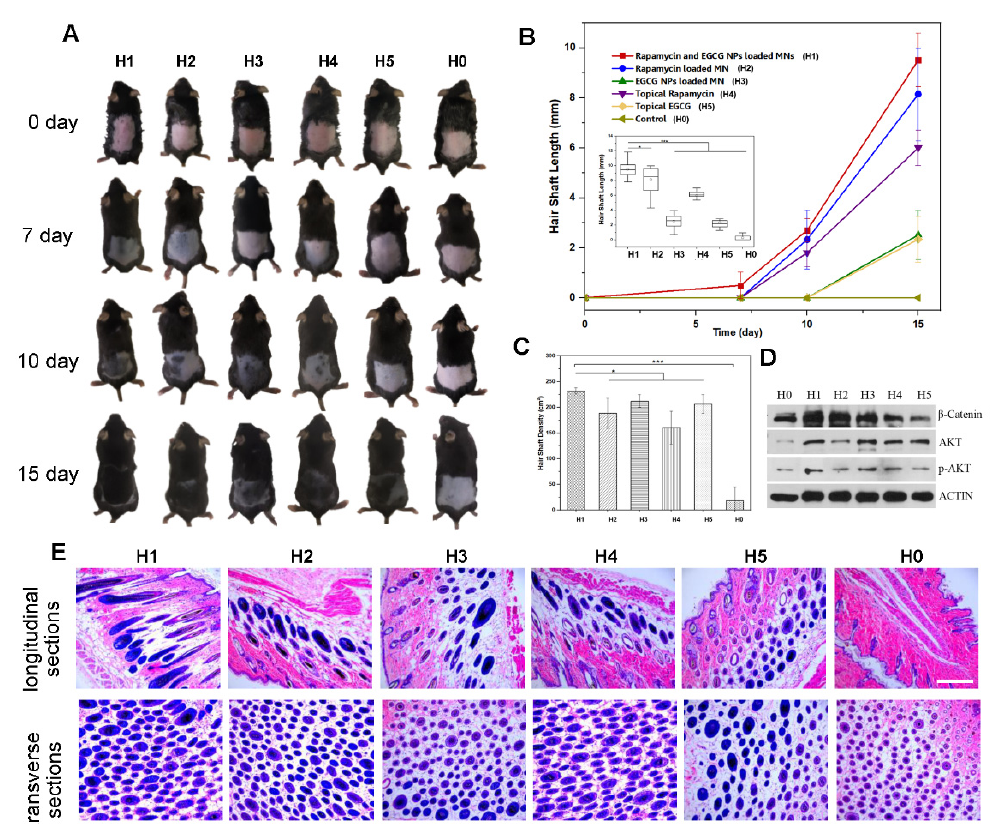
Figure 6. In vivo study of DMN for hair regrowth. ( A ) Physical images of mice treated with RAPA- PLGA and EGCG-KE NP-loaded MNs (H1), RAPA-PLGA-loaded MNs (H2), EGCG-KE NP-loaded MNs (H3), topical RAPA (H4), and topical EGCG (H5). Untreated mice (H0) served as a control. ( B ) Hair shaft analysis chart of new hair grown on treated mouse dorsal skin as a function of treatment time and day 15 ( n = 3, mean ± SD). ( C ) Hair follicle density analysis chart of new hair grown on treated dorsal skin at day 15 ( n = 3, mean ± SD). ( D ) Western blotting assay of the expression level of proteins related to hair follicle growth activation ( β -Catenin, p-AKT). ( E ) H&E staining images of longitudinal sections (top) and transverse sections (bottom) of mouse dorsal skin (scale bar: 100 μ m). A probability value ( p < 0.05) by t -test was considered significant (* p < 0.05, *** p < 0.001).